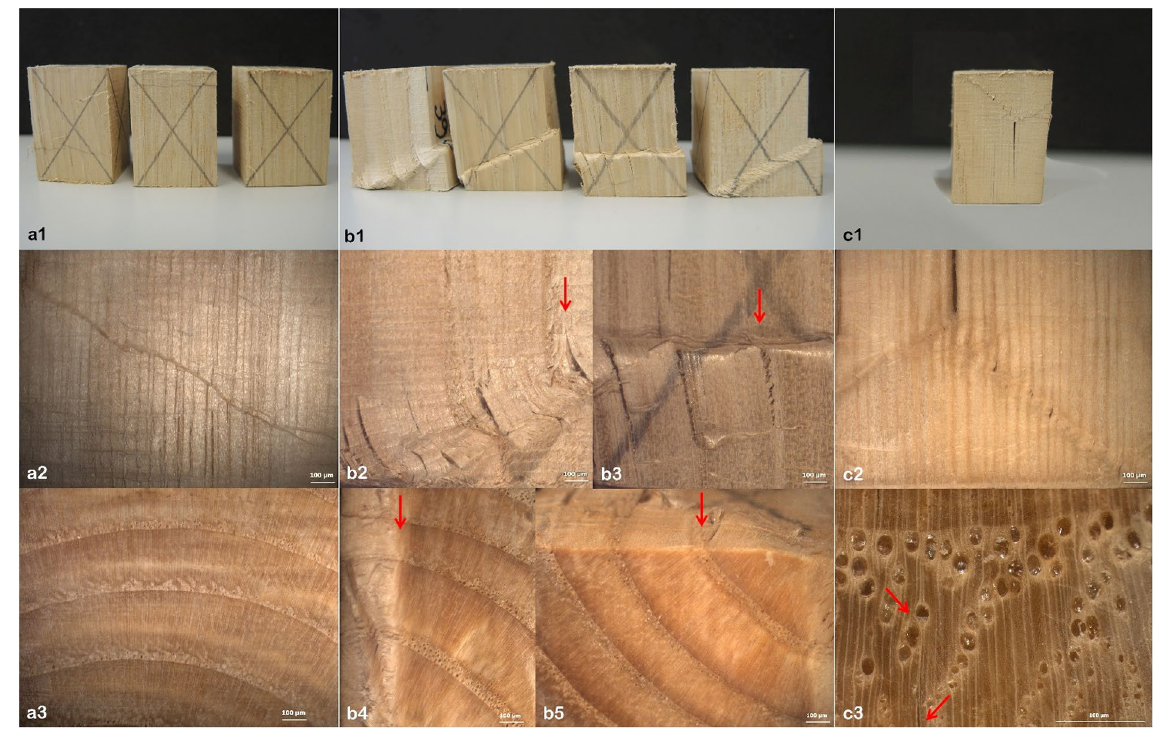
Figure 4. The column ( a ) is with samples showing highest mechanical strength. The break line is not so evident on longitudinal side. In the column ( b ), the typical rupture at compression strength of the most samples. In ( b2 ) and ( b3 ) it is evident a split in the tissues. In ( b4 ) there is an overlapping of radial size in the cross-cut side due to compression stress. In ( b5 ) the rupture of ( b3 ) is located at the end of ring width in the transition from latewood to the earlywood of the next ring. The rupture in ( c1 ) is in the less resistant specimen, the cleavage break occurs in the cell walls of latewood vessels and it is in specimen with more gradual transition from the ring porous to latewood vessels.